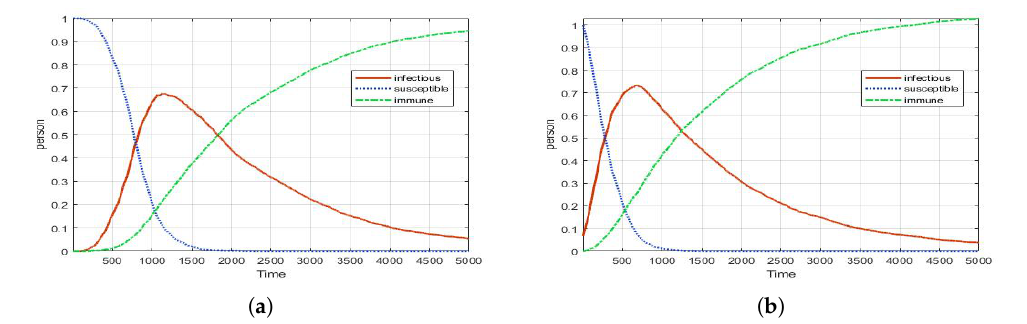
Figure 12. The effect of Super-spreaders whereabouts (No-control): ( a ) Super-spreader is in GP (peak: 0.68); ( b ) Super-spreader is in CP (peak: